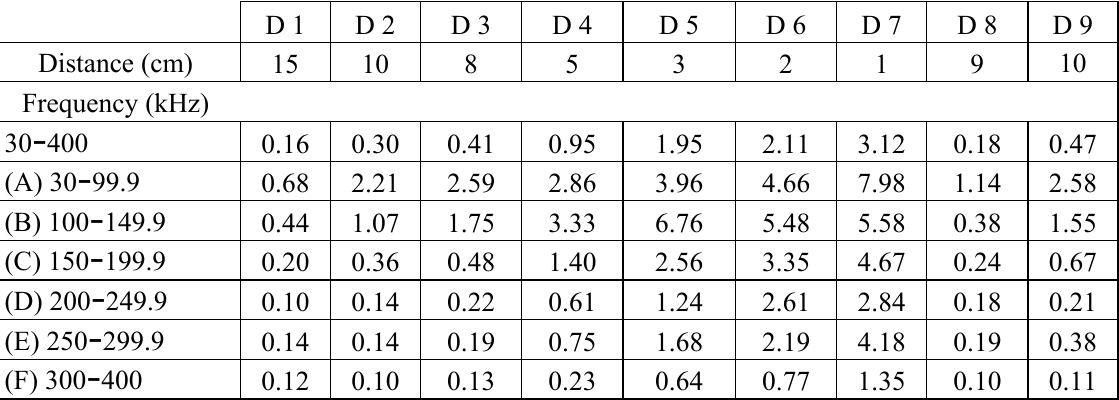
Table 1. RMSD-S for PZT 5.